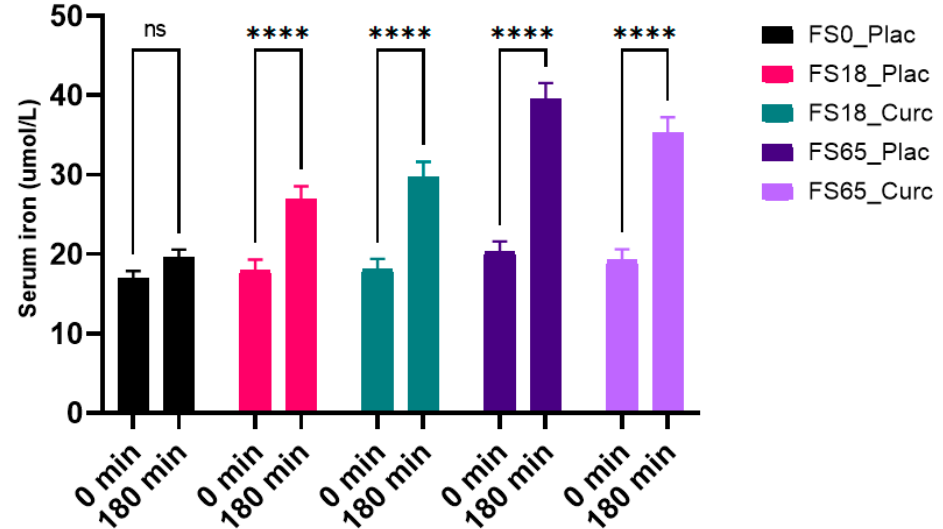
Figure 2. Serum iron levels at baseline and 180 min following supplementation. Results are presented as mean ± SEM Serum iron levels (µmol/L). ns indicates no significant difference ( p > 0.05); * represents significance values when comparing time points within the same the conditions (**** p < 0.0001).